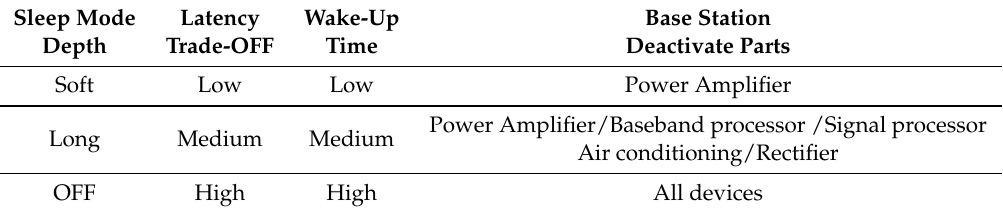
Table 4. Control application